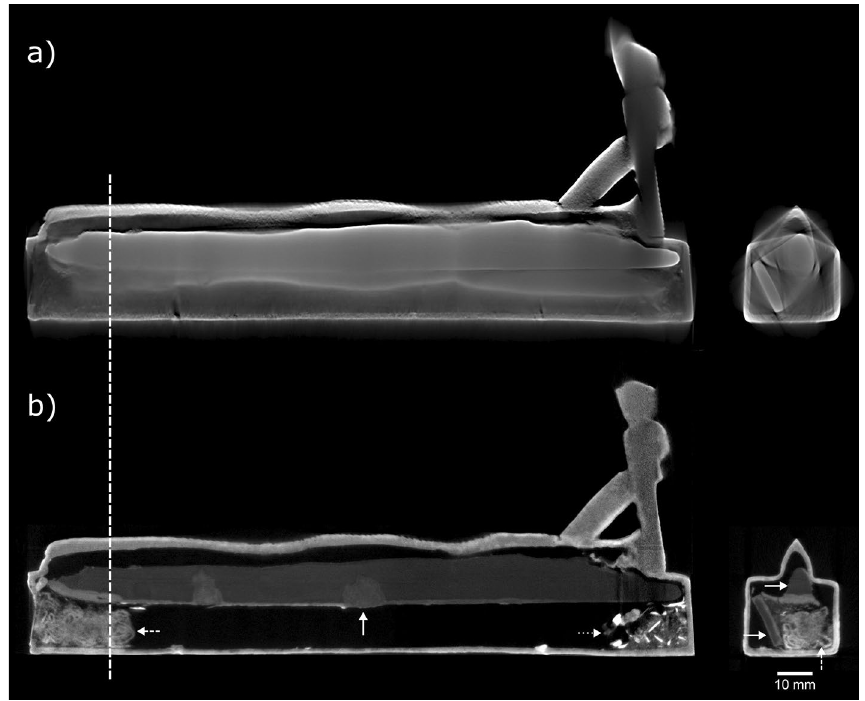
Figure 5. EA71428 ( a ) X-ray and ( b ) neutron CT slices (side-view and front-view). Front-view slices taken at the position marked by the dashed line. The neutron CT images are averaged over two adjacent planes (giving a 0.110 mm slice thickness), to approximately match the X-ray CT data (0.108 mm slice thickness). Solid arrows: lead pieces (in the neutron CT side-view, the arrow is centred on a region of deep lead corrosion in the upper lead piece); dashed arrows: textile in plug; dotted arrow: loose fragments. X-ray CT data were acquired during the previous study 9